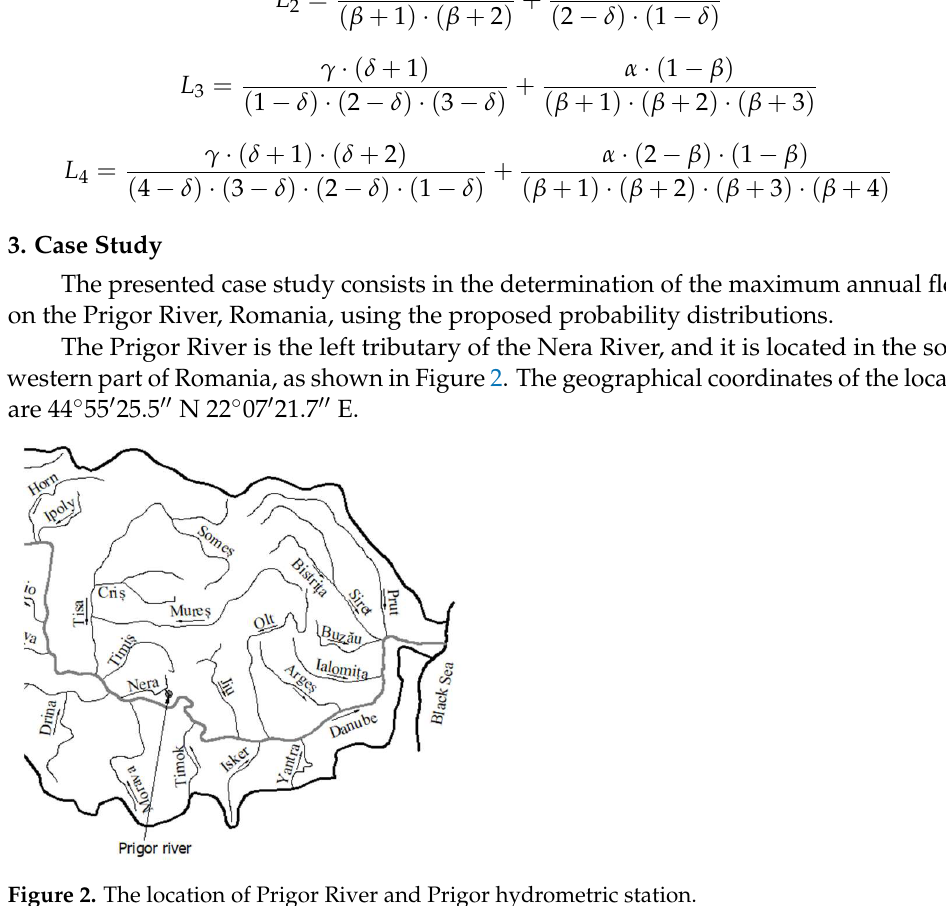
Table 3. The morphometric characteristics.